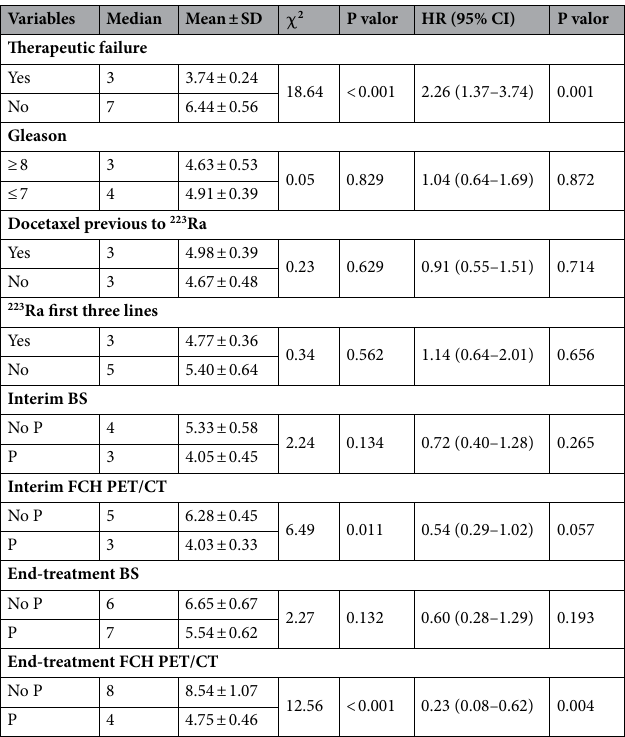
Table 4. Long rank tests and Cox regression results of association of clinical and imaging response variables with PFS. HR hazard ratio, PFS progression free survival, χ 2 Chi-squared, P progression, no P no progression, SD standarddeviation, CI confidence interval, BS bone scan, FCH PET/CT 18F-fluorocholine positron emission tomography/computed